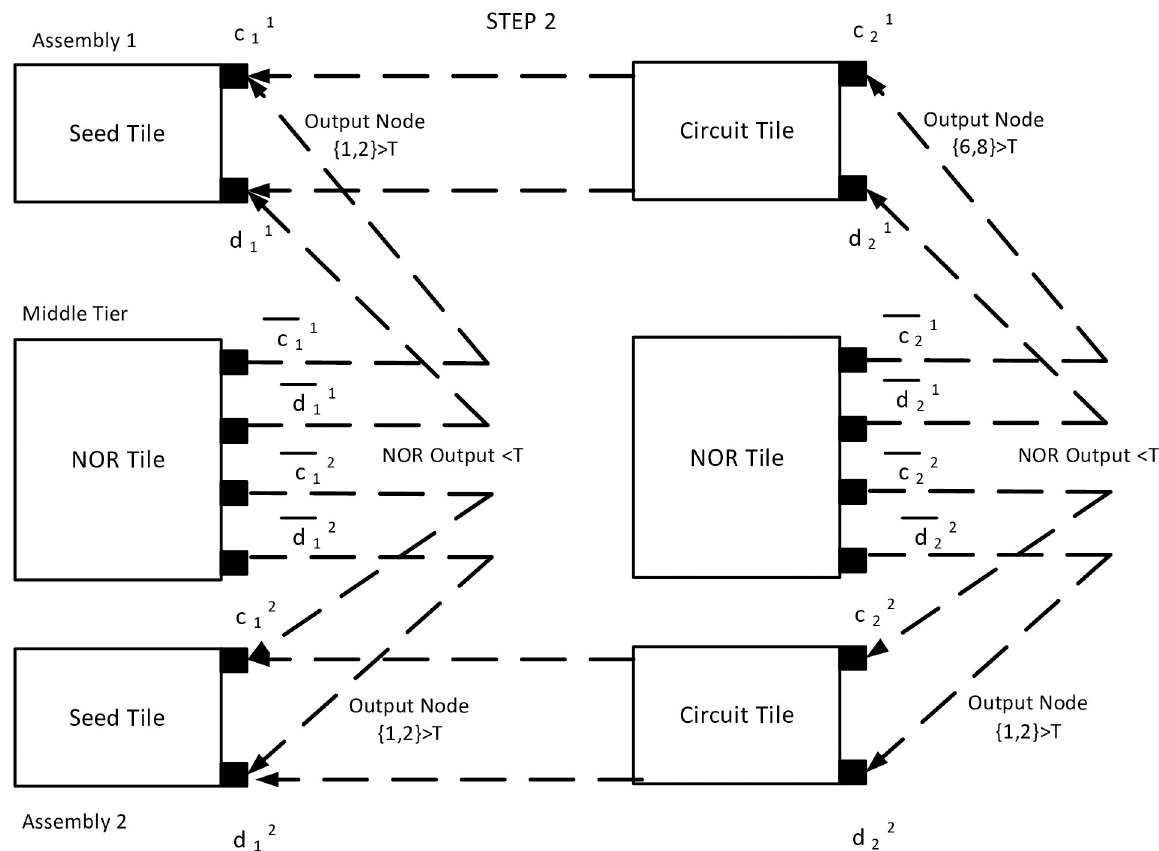
Fig 10. Step 2 of the example assembly. Here, the circuit tiles are connected to the assemblies. The second assembly has V B < t . Still, one input of the NOR tile is greater than the threshold and thus, NOR output is still < τ first assembly has V B ð 1 ; 2 Þ